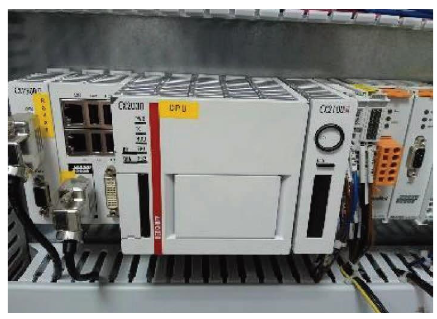
Figure 7: Te industrial PC in the semiphysical NPP simulator.